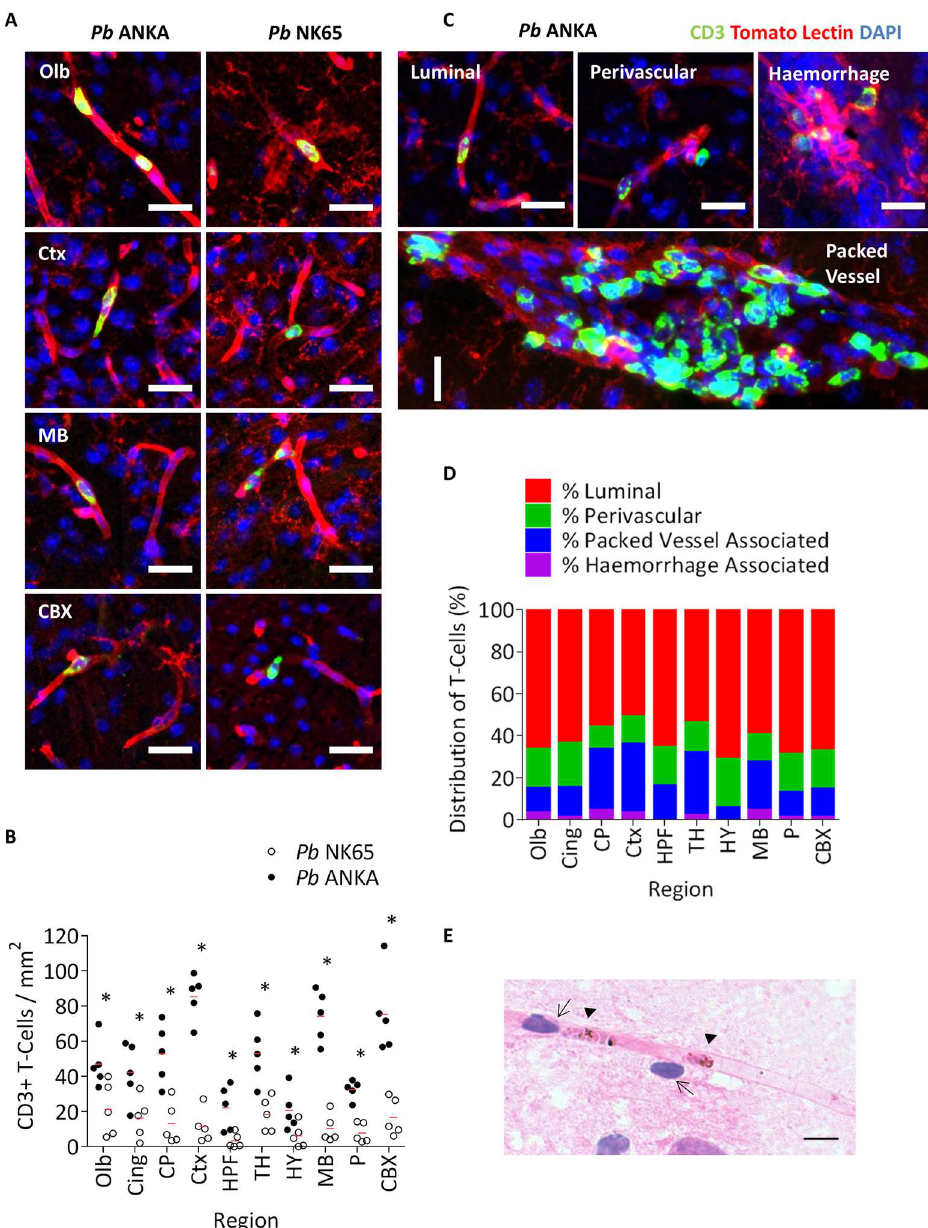
Fig 4. Intracerebral T-Cell burden is greater during ECM infection compared to non-ECM infection. C57BL/6mice were infected with 1x10 4 Pb ANKA GFP (n = 5) or 1x10 4 Pb NK65 GFP (n = 5) pRBCs. All mice were euthanisedon d7 p.i. when Pb ANKA infected mice developed late-stage ECM. Brains were removed from transcardiallyperfused mice and examinedvia immunofluorescence for the presence of CD3 + T-cells (green)in relationto lectin-labelled vasculature and activated macrophage(red), with nuclei counterstained blue. (A) Representative immunofluorescent images of vessel-associatedCD3+ T-cells in the olfactory bulbs, cortex, midbrainand cerebellarcortex of brainsfrom mice infected with Pb ANKA and Pb NK65. (B) Quantitation of CD3+ T-cells within the different brain regionsof Pb ANKA and Pb NK65 infected mice. (C) Representative images demonstrating the different presentation of CD3 + T-cells in the brainsof mice infected with Pb ANKA. (D) Quantificationof the frequency (%) of CD3 + T-cells, (out of total observedCD3 + T-cells), that were; luminal,perivascular, haemorrhage-associated, or packed-vessel associated. (E) H&E stained brain smears taken from transcardially perfusedmice on d7 p.i. (n = 5) showingluminaland abluminal lymphocytes ( " note the distinctive dark nuclear stainingand nuclear:cytoplasmic ratio) in close proximity to mature, sequestered pRBCs ( ▲ ). Dots represent mean of individualbrains, with red lines mean of total